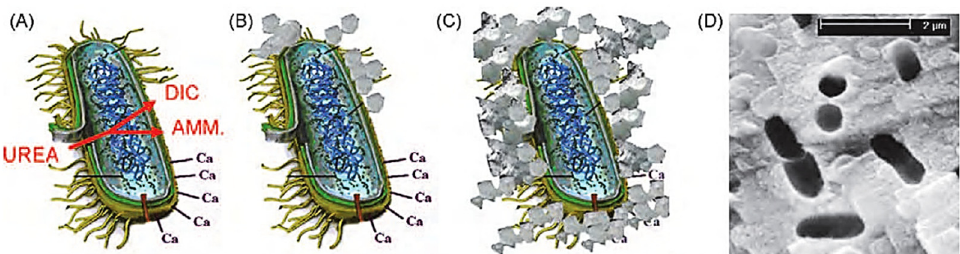
Figure 2. Simplified representation of events occurring during microbially induced carbonate precipitation. Calcium ions in the solution are attracted to the bacterial cell wall due to the negative charge of the latter. When urea is added to the bacteria, dissolved inorganic carbon (DIC) and ammonium (AMM) are released into the bacteria microenvironment ( A ). In the presence of calcium ions, this can cause local over-saturation and thus heterogeneous precipitation of calcium carbonate on the bacterial cell wall ( B ). Subsequently, the entire cell is encapsulated ( C ), limiting nutrient transfer, resulting in cell death. The image ( D ) shows the imprints of the bacterial cells involved in the precipitation of carbonate [28].